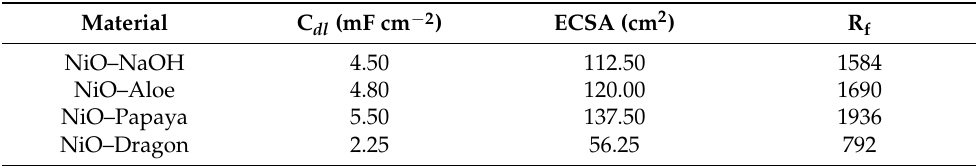
Table 3. Electrochemical active surface area and double-layer capacitance of NiO x nanoparticles.